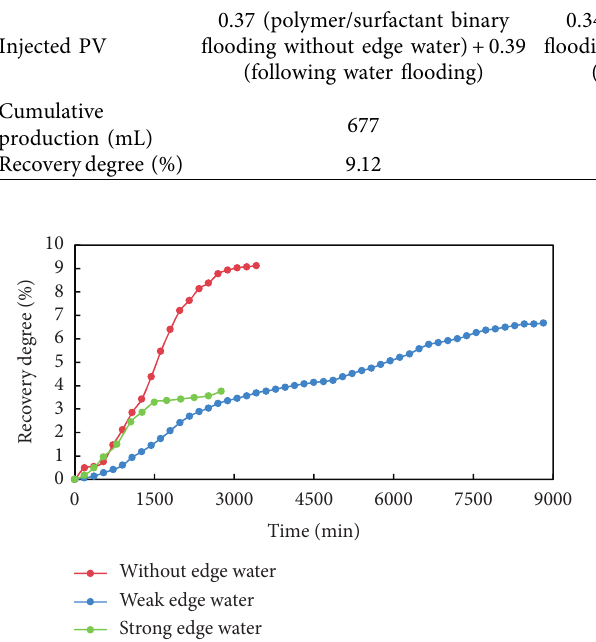
Figure 4: Curves of the recovery degree under different edge water energy conditions.